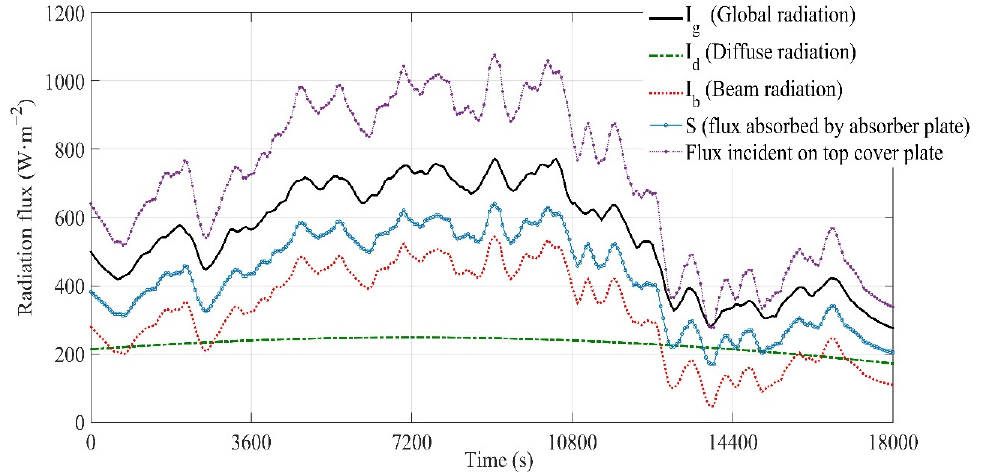
Figure 4. Record of radiation flux measured on a clear day.